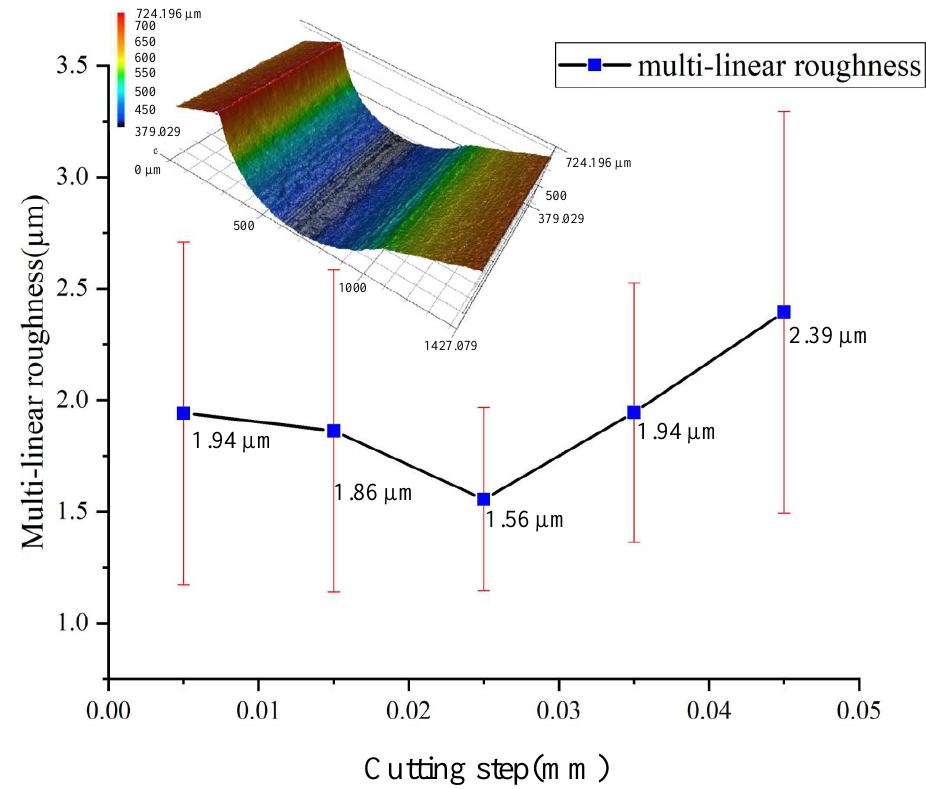
Figure 16. Multilinear roughness (Ra) for each cutting